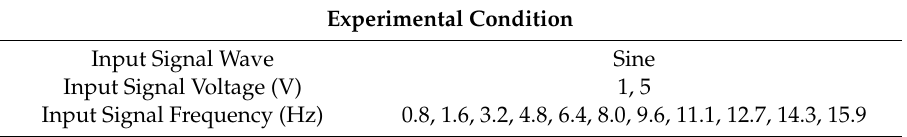
Figure 7. Schematic diagram of working principle of the IPMC actuator. Table 2. Experimental conditions of lab-scale harvester prepared in this